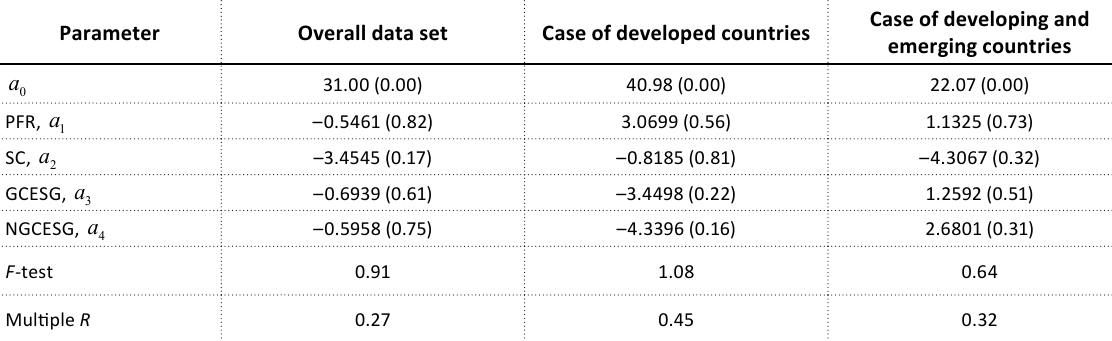
Table 3. Multiplied regression analysis: ranking in 50 largest economies ( Y ) and ESG disclosure regulation variables ( X